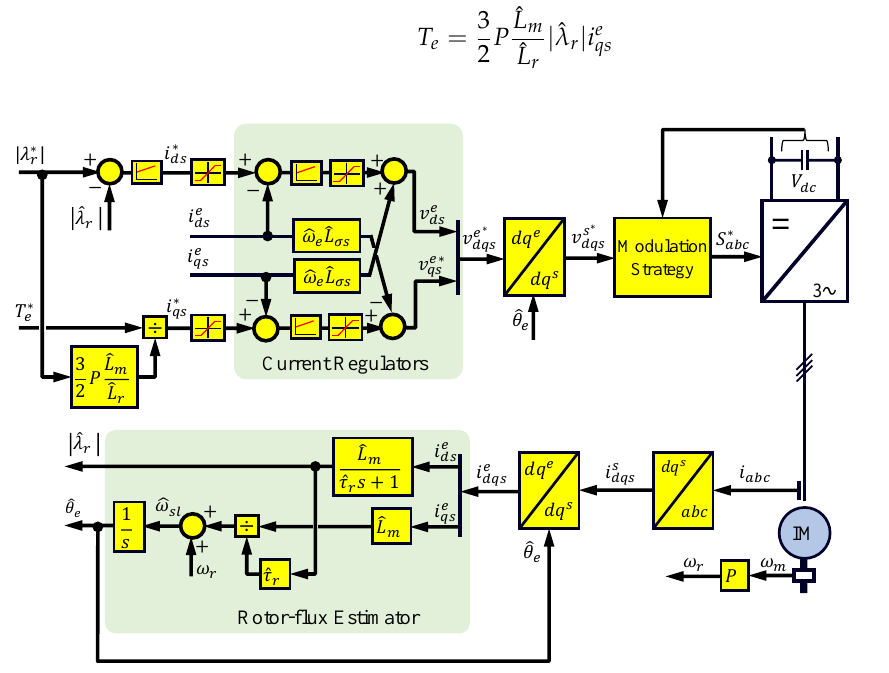
Figure 2. Rotor field-oriented control (RFOC)